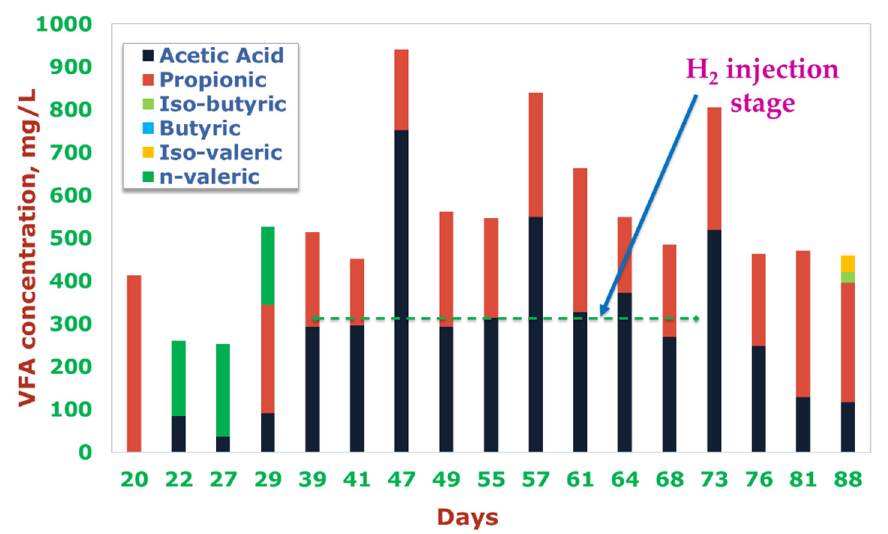
Figure 3. Effect of H 2 injection on the digester’s volatile fatty acids (VFA) development. The VFA data presented in this graph correspond to the values at sampling days on which analyses were conducted, and hence should not be interpreted as the actual VFA effect on those days. The day-specific actual VFA effect corresponding to the experimental progress might remain undetected, as the interval between the measurements was high and the analysis results obtained were dependent on an external lab. Regardless, the VFA formation trend is clearly demonstrated.